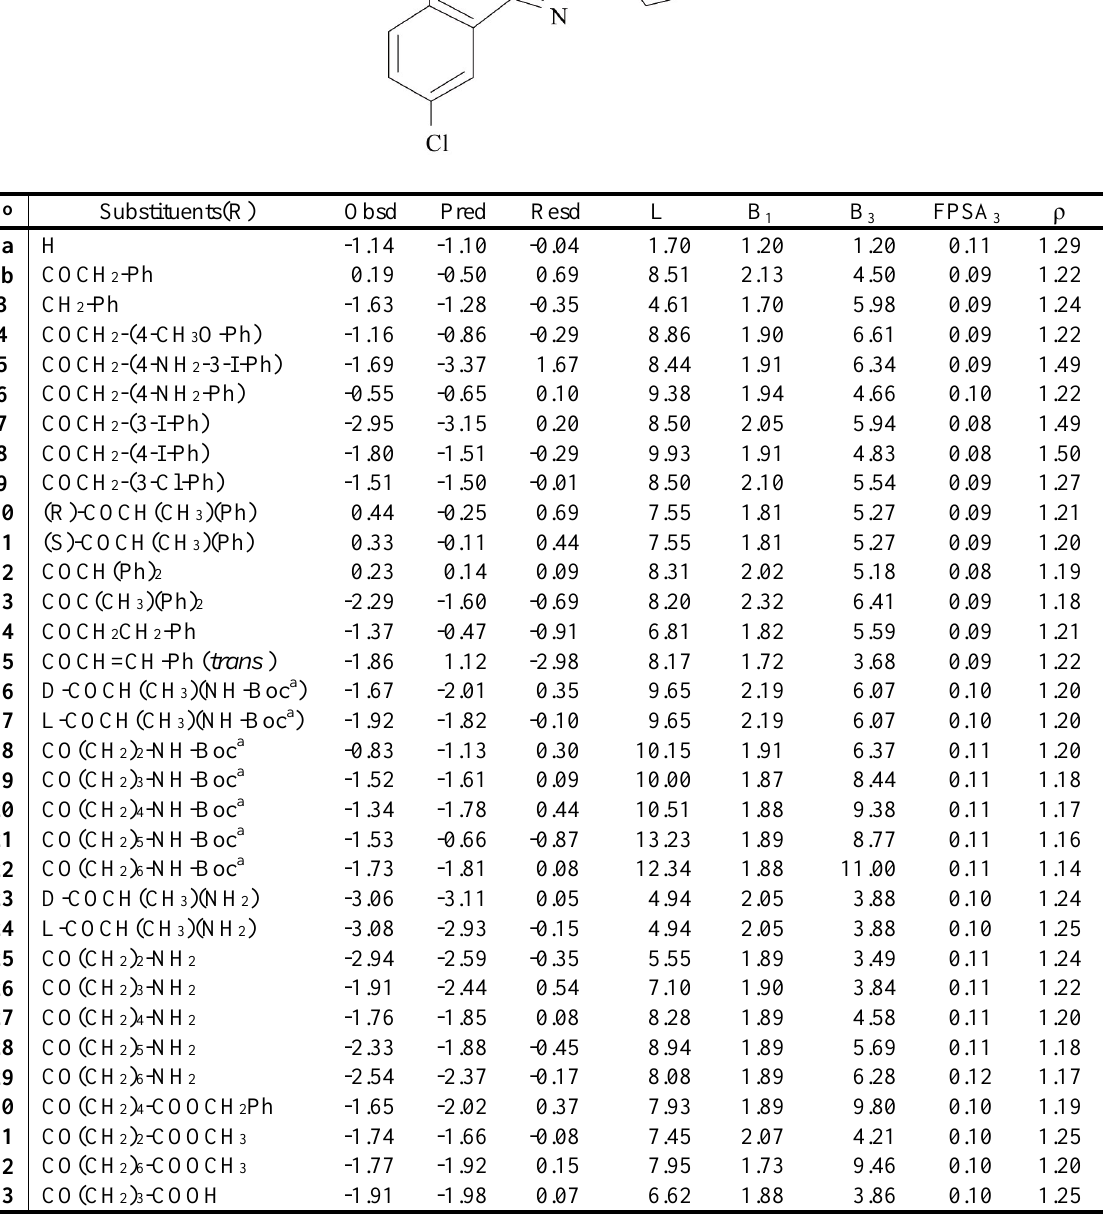
Table 3 . Binding affinities and descriptor values from QSAR equation